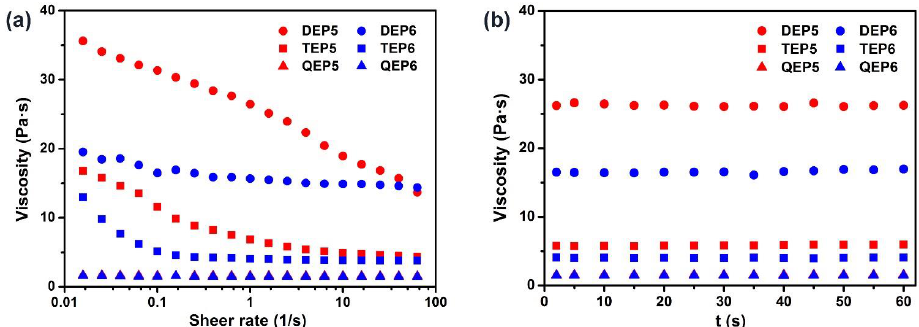
Figure 1. Rheological behaviors of the six liquid pillar[n]arene derivatives. Flow curves show ( a ) viscosity vs. shear rate over an extended range from 0.01 to 100 s −1 and ( b ) viscosity vs. time at a shear rate of 1 s −1 .